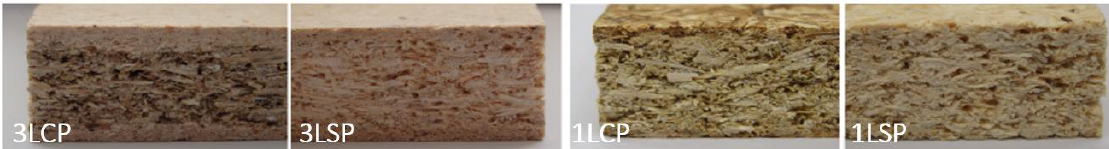
Figure 1. Cross-sectional views of the produced particleboards. 3LCP—three-layer particleboard (PB) with a cup-plant core layer, and spruce surface layers; 3LSP—three-layer spruce PB, 1LCP—single layer cup-plant PB, and 1LSP—single layer spruce PB.